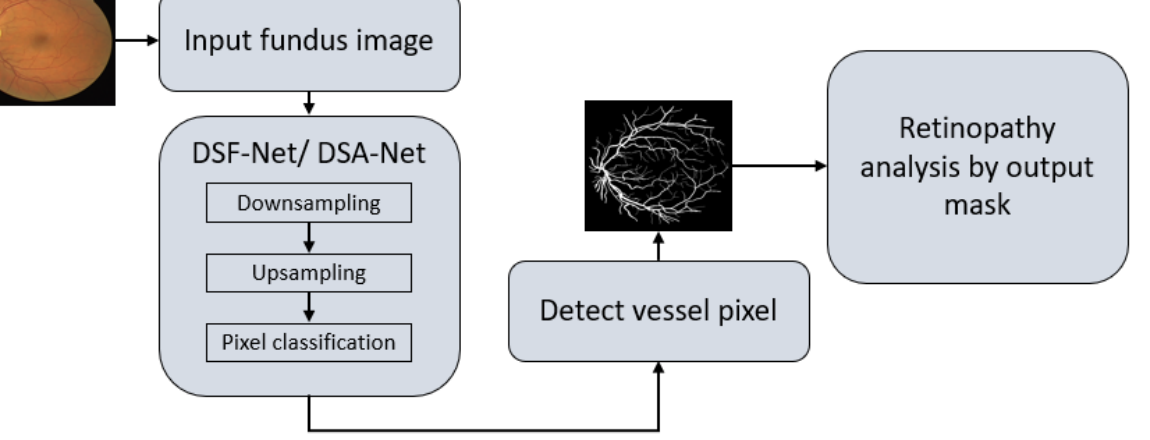
Figure 4. Overall summary of the proposed retinopathy analysis using DSF-Net or DSA-Net. Abbreviations: DSF-Net, dual stream fusion network, DSA-Net, dual stream aggregation network.